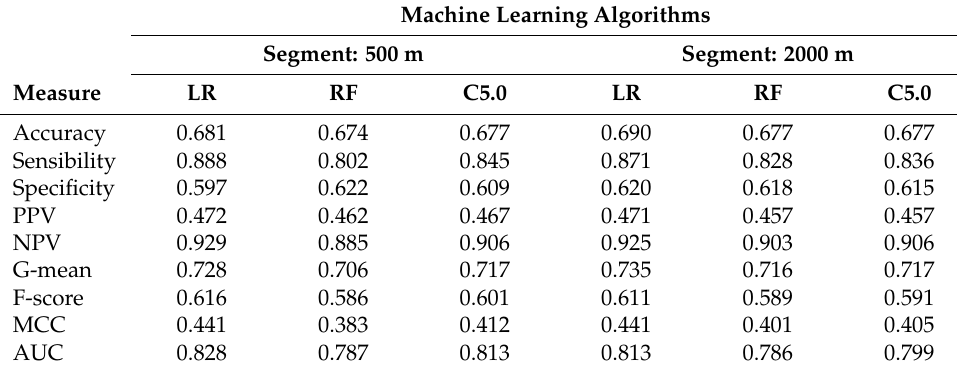
Table 1. Performance measures for the Logistic Regression (LR), Random Forest (RF) and C5.0 algorithms, by road segments length (500 m and 2000 m), for the RNS